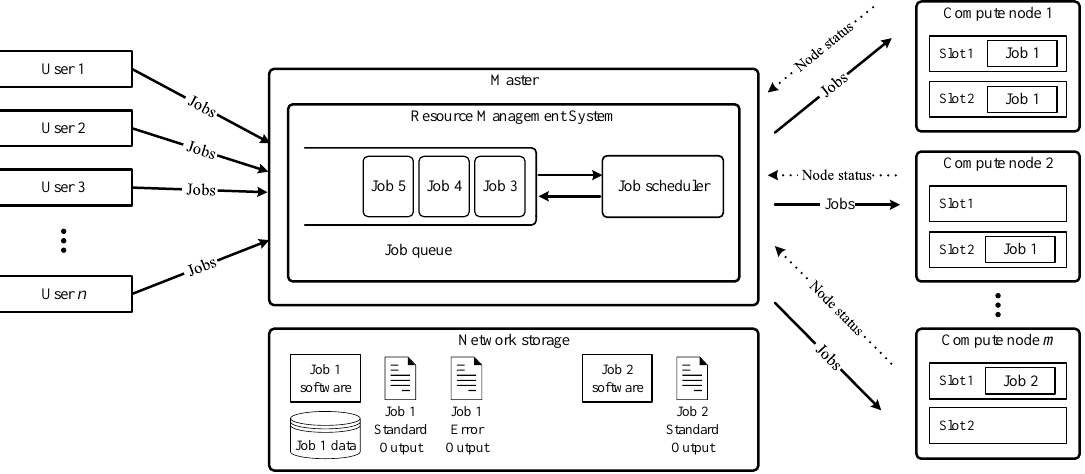
Figure 1. Resource management system components using only one master